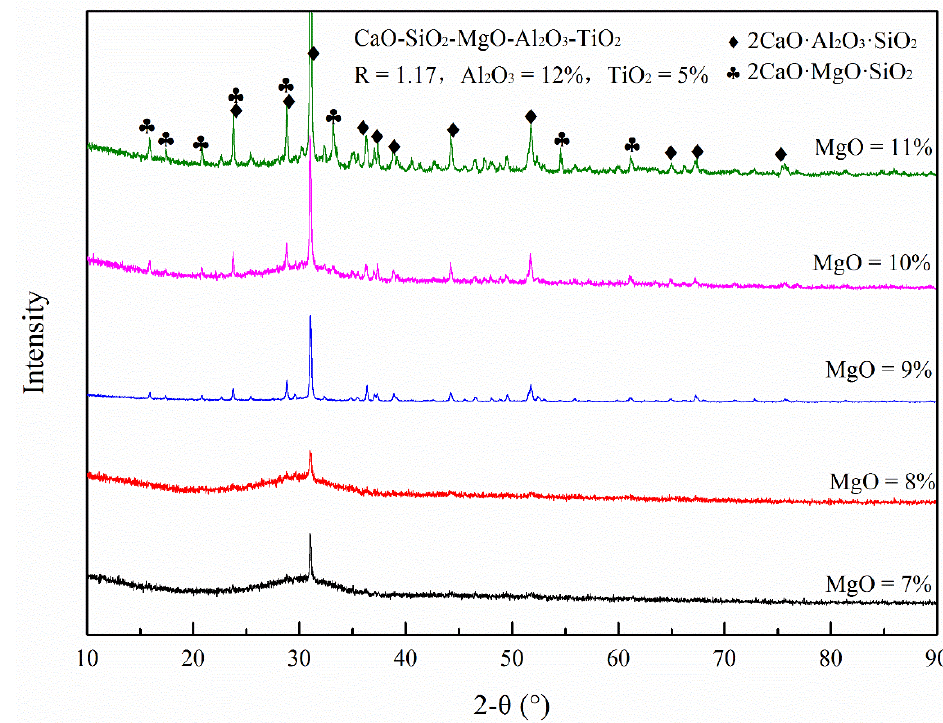
Figure 8. XRD patterns of naturally cooled BF slag with different contents of MgO.